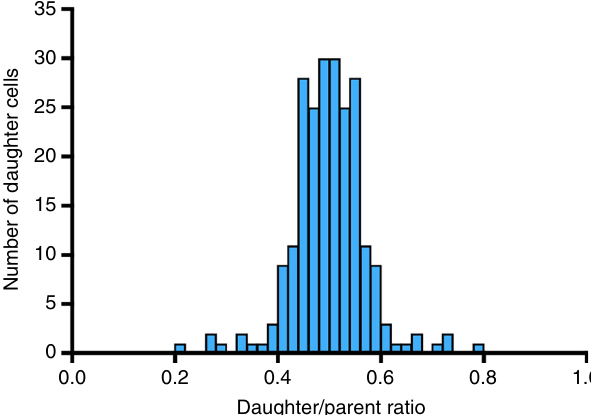
Fig. 4 RB replication by binary fi ssion. Size histogram of nascent daughter cells at 24 h.p.i. The daughter/parent ratio was calculated as the volume ratio of each daughter cell to its dividing RB parent 27 . Volumes were measured for 228 daughter cells from 114 dividing RBs in two 24